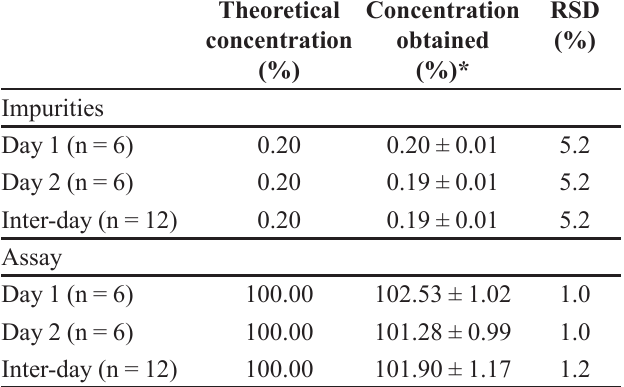
TABLE III - Amiodarone hydrochloride precision (*data are means ± SD)